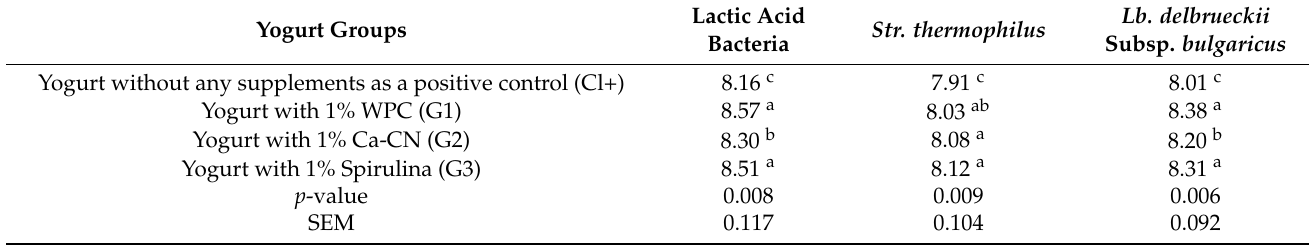
Table 4. Microbiological examinations (log 10 CFU g − 1 ) of yogurt fortified with milk protein concentrates and Spirulina powder.